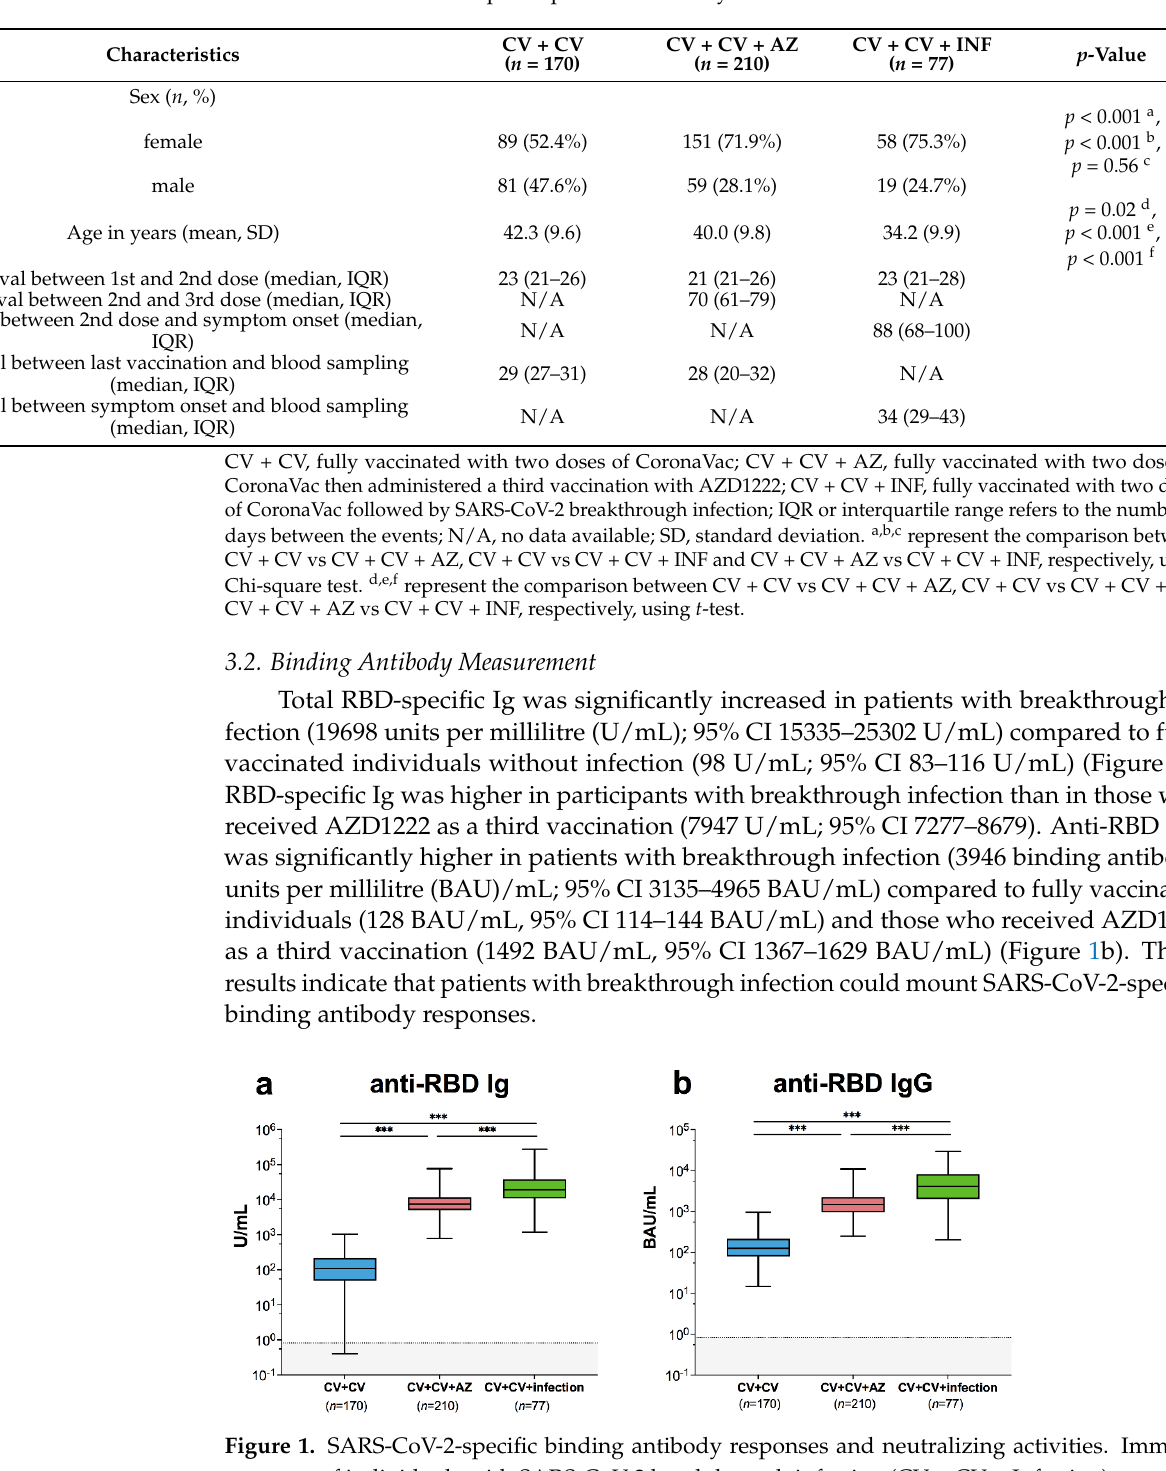
Table 1. Characteristics of participants in the study.